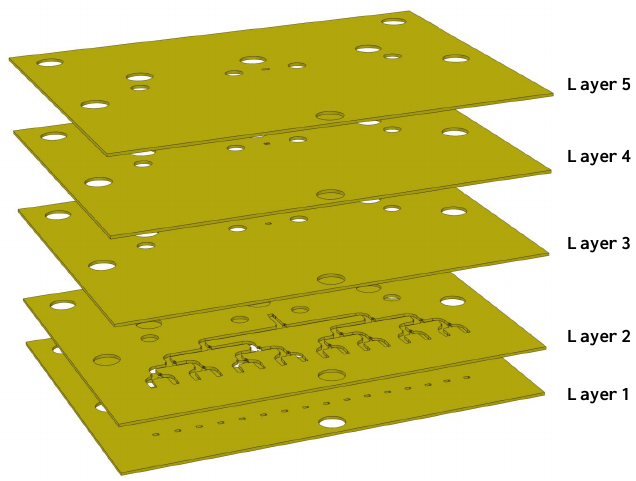
(b) Figure 12. Exploded view of the five-chip stack forming the 16-way power divider.